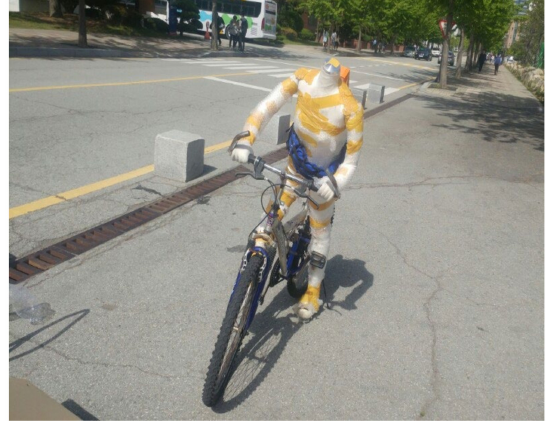
Figure 1. Mannequin and